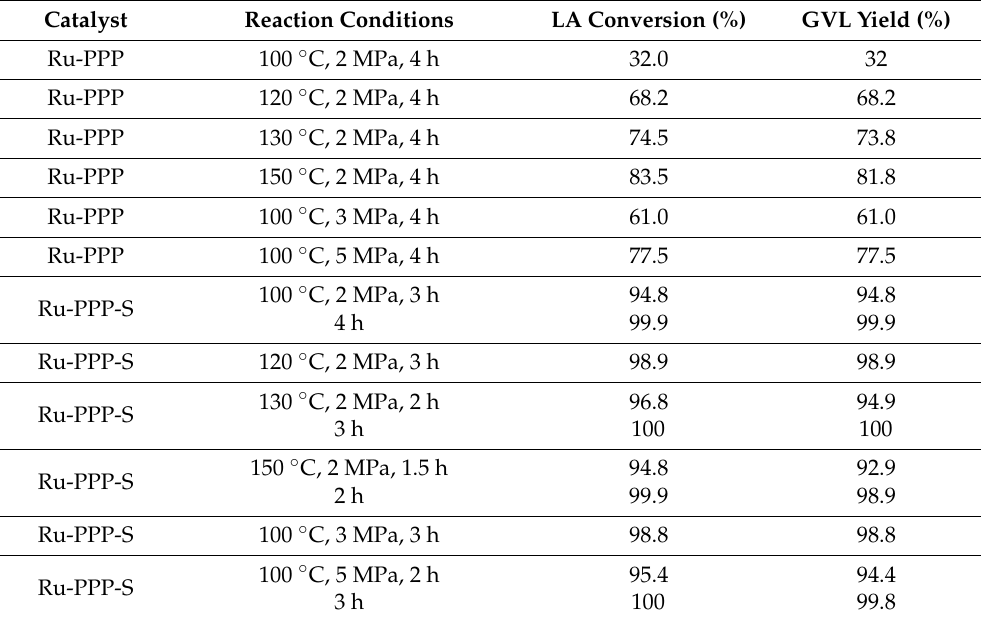
Table 1. The results of LA hydrogenation in the presence of the Ru-PPP and Ru-PPP-S catalysts.